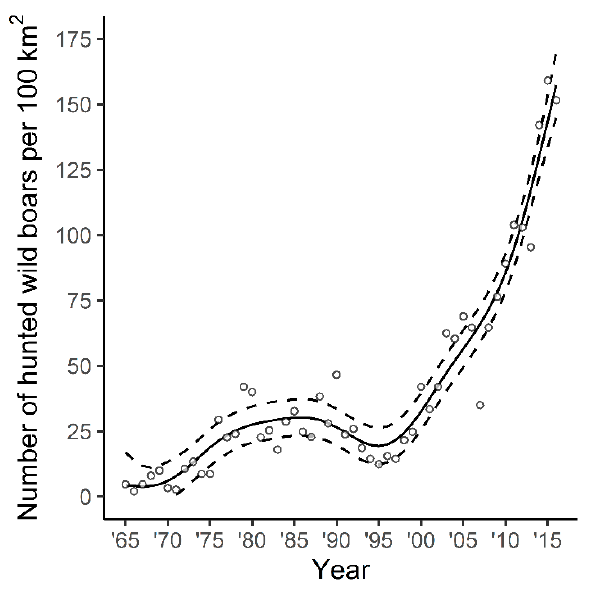
Figure 2. Number of culled wild boar per 100 km 2 during the study period. The curve is the prediction obtained from the fitted generalised additive model, dashed lines show 95% confidence intervals.